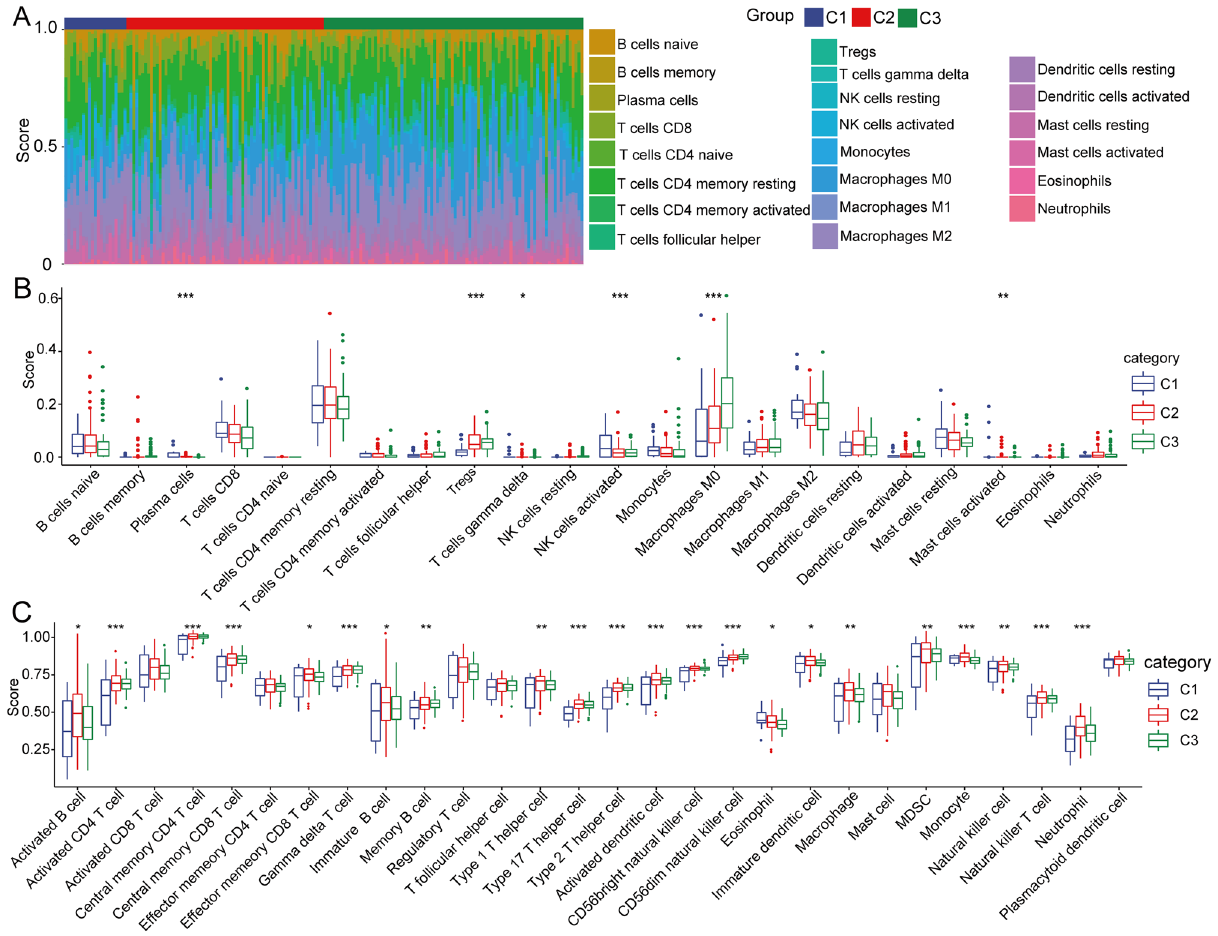
Figure 5. Characteristics of immune cell infiltration in different clusters. ( A ) Distribution of 22 immune cell scores in 3 subgroups. ( B ) Differences in 22 immune cell components in samples from different clusters. ( C ) Differences in ssGSEA immune scores among different clusters. (* P < 0.05; ** P < 0.01; *** P <